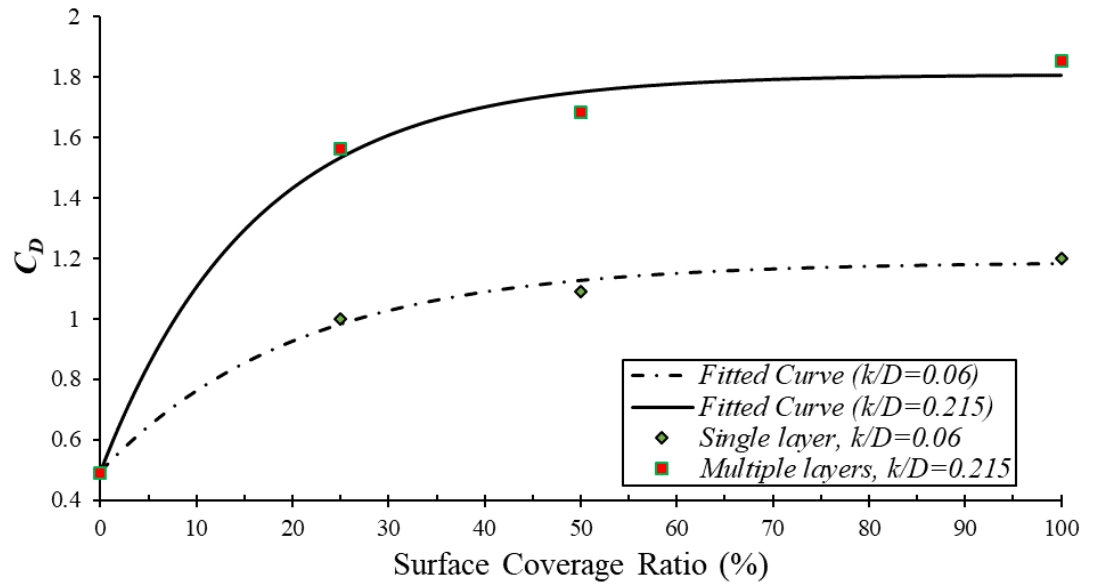
Figure 10. Evolution of drag coefficient ( C Ds ) as a function of surface coverage ratio for different aggregation patterns (rebuilt from data of [31]).